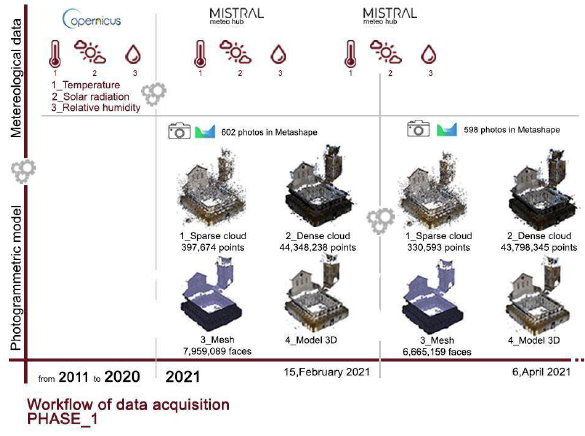
Figure 6. Workflow of data acquisition. Integration of meteorological data and 3D